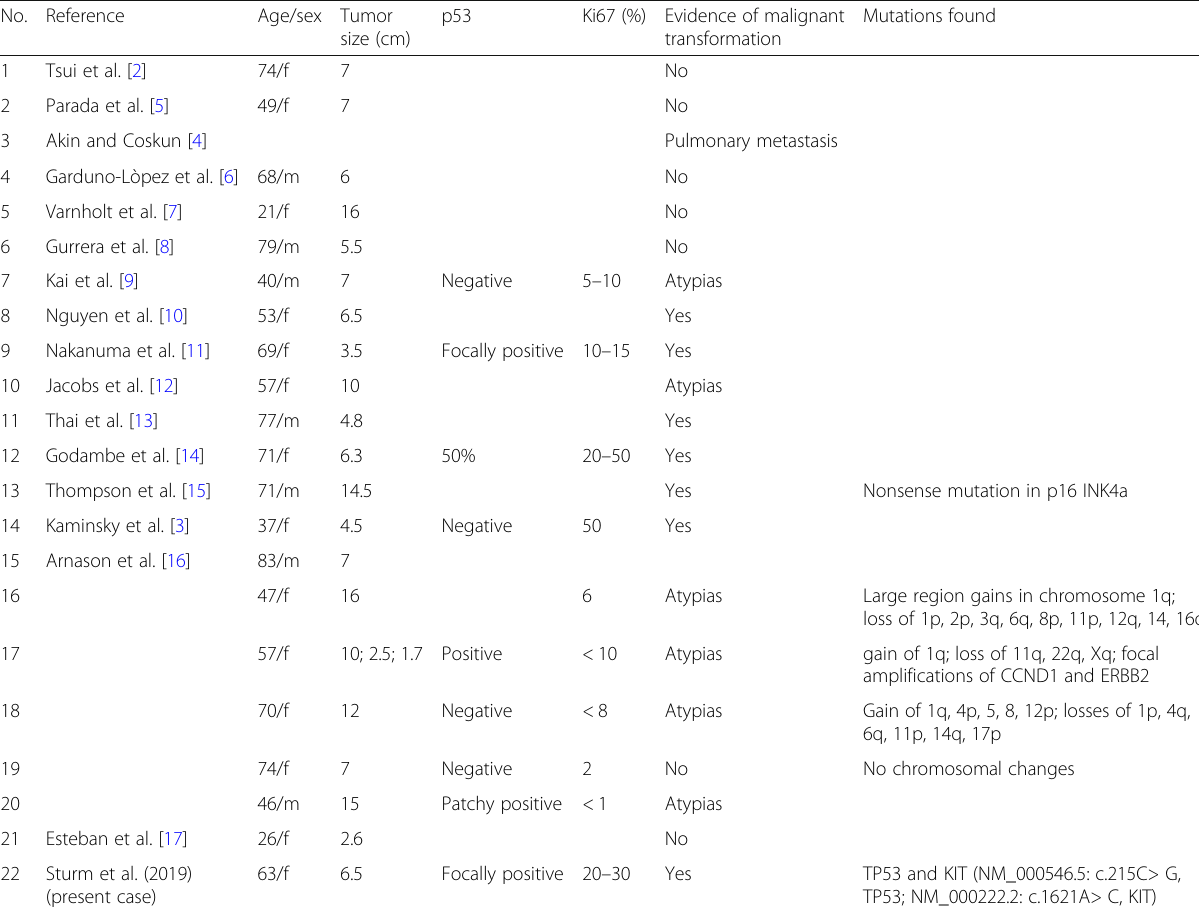
Table 1 Reported biliary adenofibromas of the liver ( n =